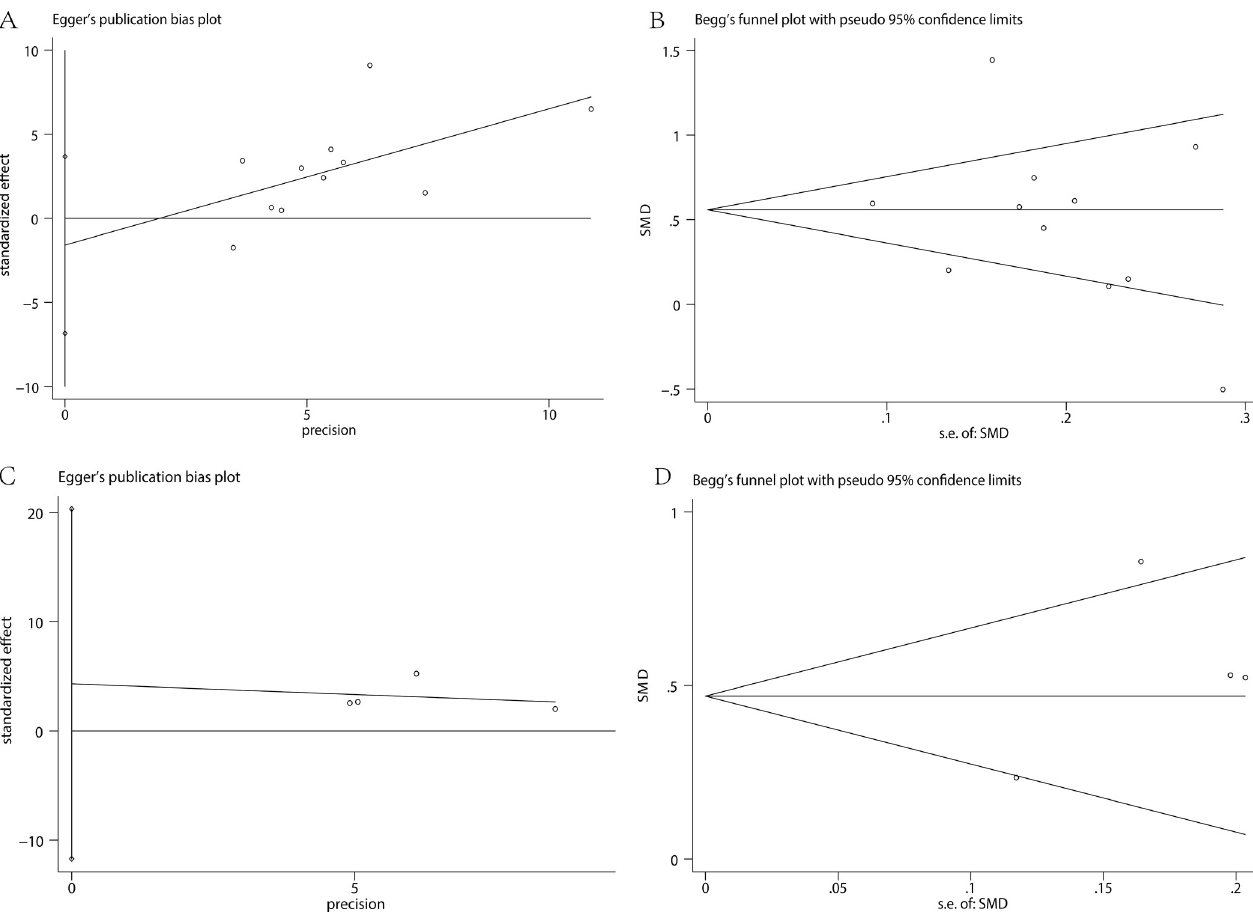
Fig 4. Publication bias of studies assessing MPV and RDW: Egger’s and Begg’s test of MPV (A and B) and RDW (C and D).